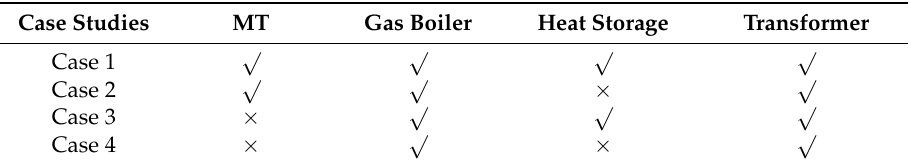
Table 1. Four cases of energy facilitator.